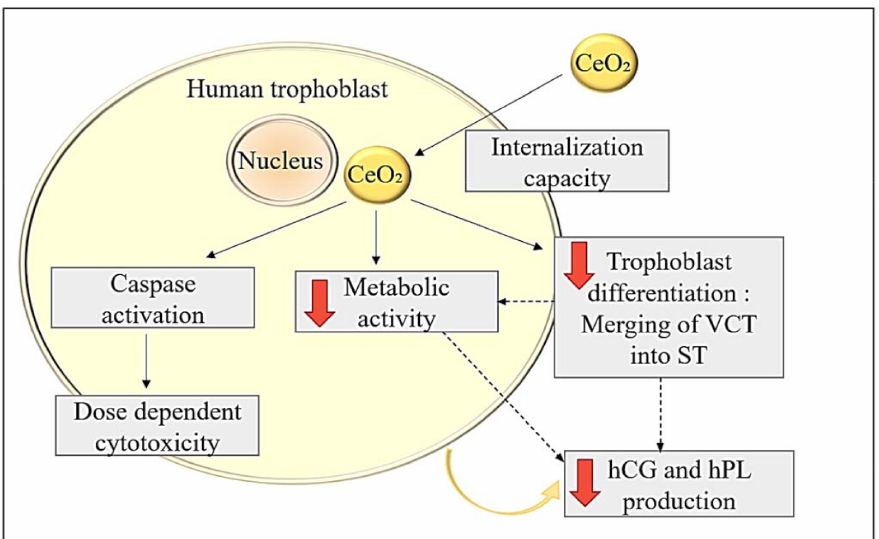
Figure 4. Impacts of nanoceria on term primary human trophoblast cultures. CeO 2 NPs are internal- ized in human trophoblasts which exhibit dose-dependent cytotoxicity, with activation of caspases. CeO 2 NPs decrease the metabolic activity of trophoblasts and also their capacity for differentiation by fusion into a syncytiotrophoblast. The endocrine activity of trophoblasts is disturbed by these CeO 2 NPs as there is a decrease in the production of hCG and